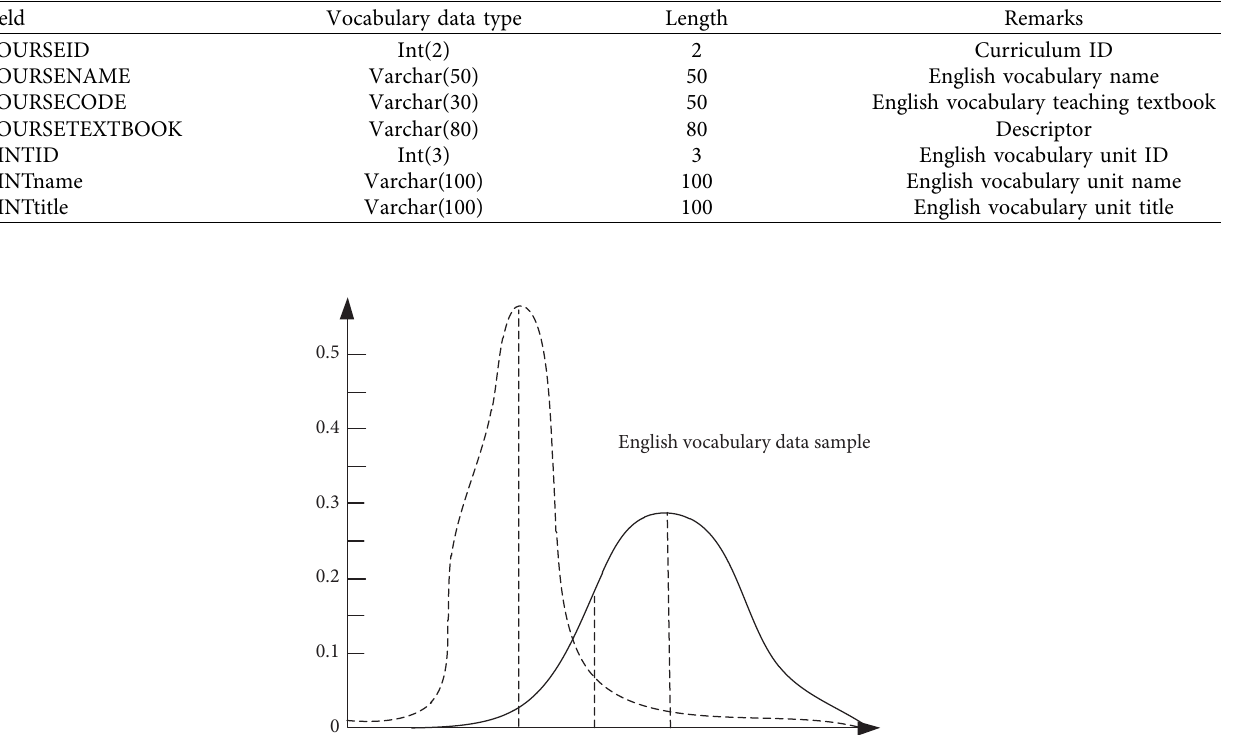
Table 2: Field settings of English vocabulary in the database.